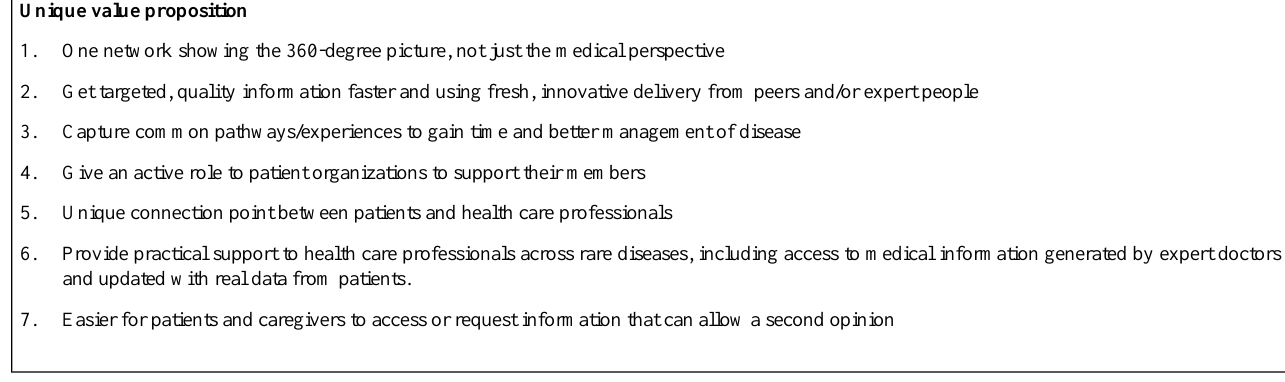
Table 3. Top features and feature types—which features will make the unique value proposition a reality?